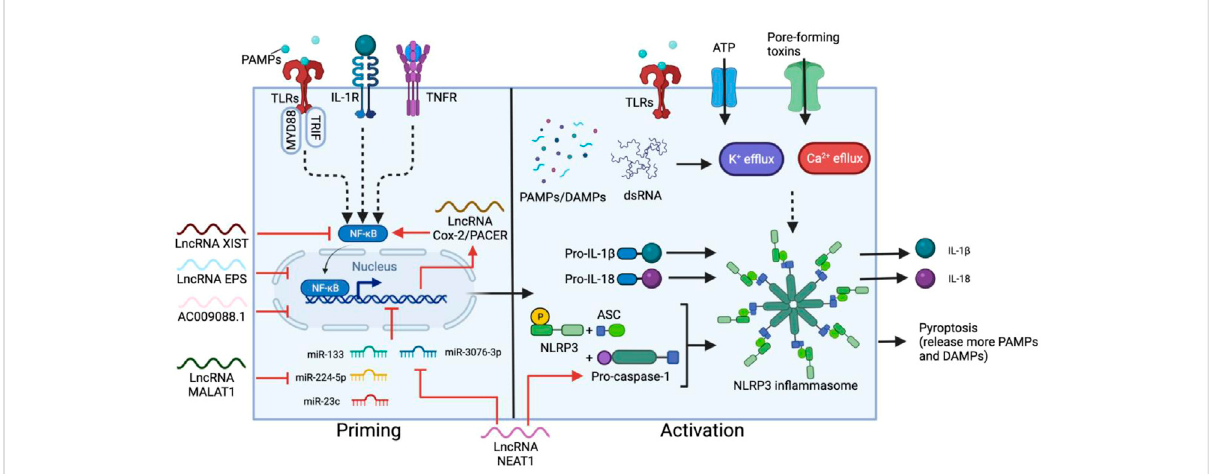
FIGURE 2 Two-step activation of NLRP3 in fl ammasome and the main regulatory lncRNAs. The priming step can be triggered by ligand recognition of TLRs, cytokine (such as IL-1) receptors and TNF receptors (TNFR). NF- κ B is then activated by myeloid differentiation primary response 88 (MYD88) and TRIF in the TLR pathways, resulting in nuclear translocation of NF- κ B and upregulation of NLRP3, pro-IL-18 and pro-IL-1 β . A secondary signal, such as ATP, toxins, dsRNA, DAMPs and PAMPs stimulates the activation step, leading to the assembly of the in fl ammasome containing NLRP3, ASC and pro-caspace-1, which cleaves pro-IL-18 and pro-IL-1 β into the mature cytokines. Most lncRNAs involved in this process regulate the primingstep.XISTandPACERpromotesorsuppressesNF- κ Bactivationrespectively.Incontrast,EPS,AC009088.1,MALAT1,andNEAT1regulatethe expression of primed genes. NEAT1 also participates in the activation step by stabilizing mature caspase-1 for in fl ammasome